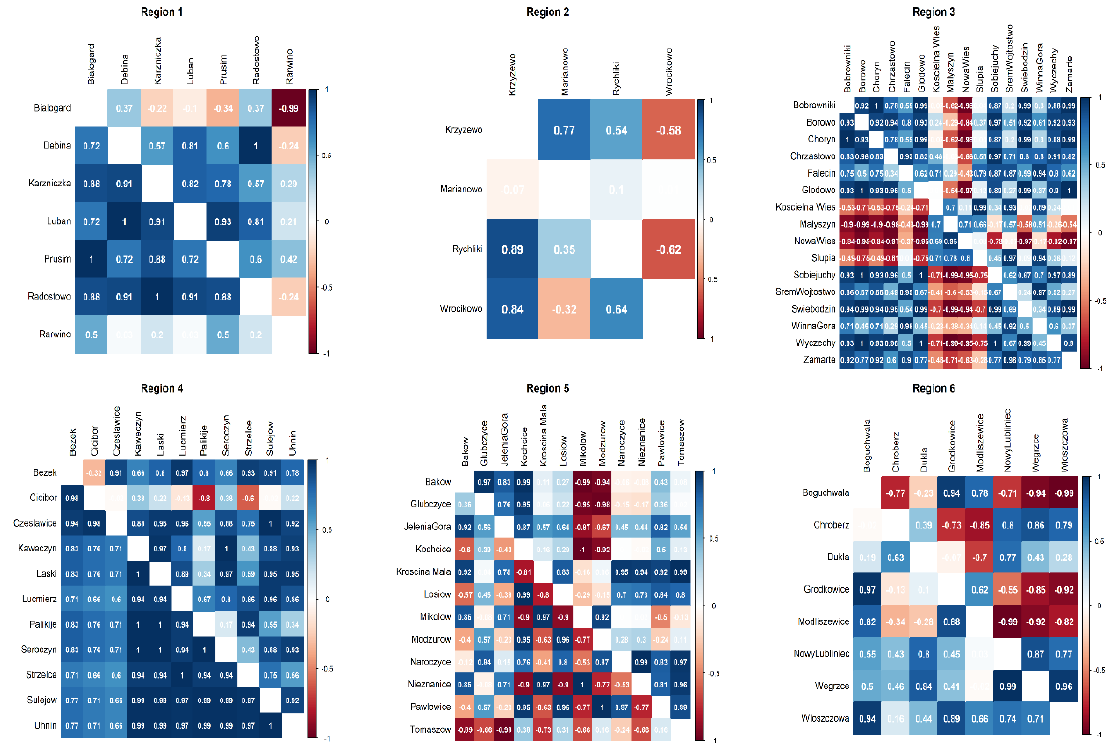
Figure 3. Spearman’s rank correlation coefficients of triticale cultivars’ rankings across trial locations in each region for each crop management (moderate-input crop management (MIM)—upper triangle, high-input crop management (HIM)— lower triangle).